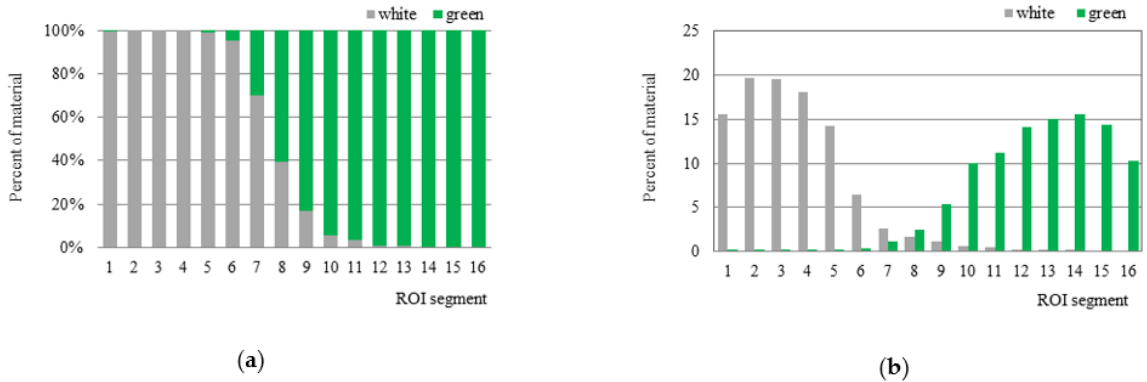
Energies 2021 , 14 , x FOR PEER REVIEW Figure 8. Results after 8 min of tribocharging and separation: ( a ) percentage of PET and PE-HD in each ROI segments; ( b ) percentage of PET and PE-HD in relation to the surface of the ROI segments.